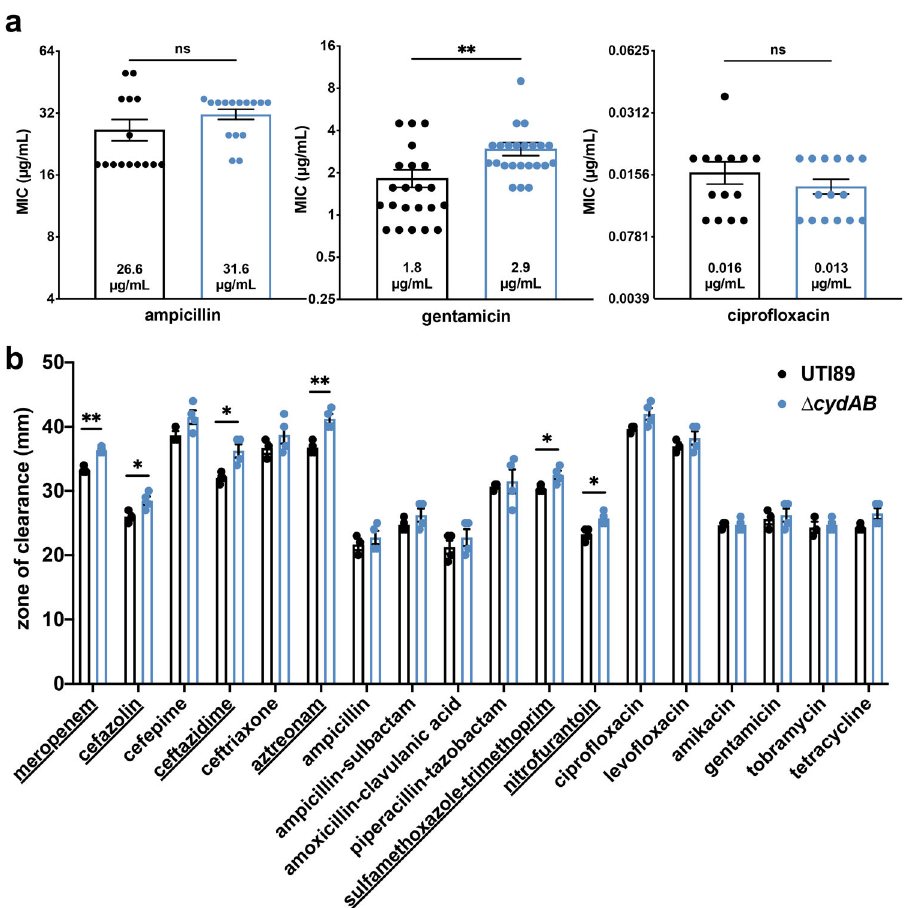
Fig. 2 Cytochrome bd has minimal effect on planktonic antibiotic susceptibility. a Graph depicting minimum inhibitory concentration (MIC) for ampicillin, gentamicin, and cipro fl oxacin. Data are representative of at least six biological replicates. Data were analyzed using a two- tailed unpaired t -test. b Graph depicting the zone of inhibition from disk diffusion assays. Data are representative of at least three biological replicates. Each dot represents a biological replicate. Mean values were statistically compared using two-tailed Welch ’ s t -test. Underlined antibiotics attained statistical signi fi cance. For all panels, data are presented as mean ± SEM. * p < 0.05, ** p < 0.01, *** p < 0.001, **** p <